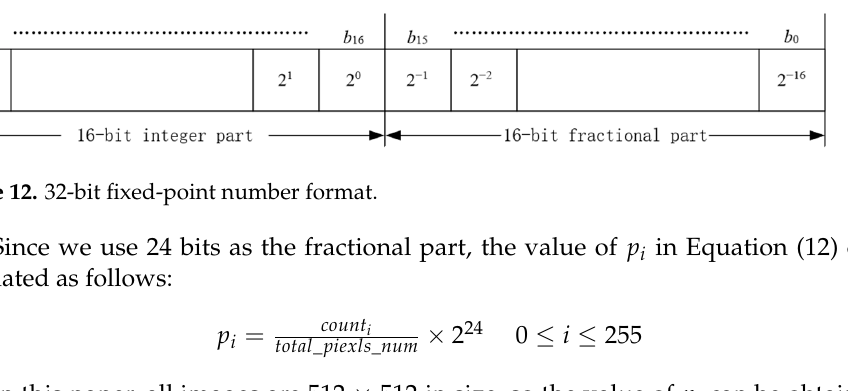
Figure 13. Architecture of Otsu’s algorithm calculation. (c) 32-bit Logarithmic Arithmetic Unit The logarithmic number system (LNS) has been studied to simplify arithmetic com- putations to achieve a lower computation complexity [26–28]. Here, a 32-bit logarithmic arithmetic unit suggested in [28] is adopted to compute Equation (14). Figure 14 shows the architecture of the logarithmic converter. It is composed of a 32-bit count leading zero (CLZ), a barrel shifter (BSH), a characteristic generator (CGen), and a fractional part gen- eration block (FPGen). The variable input number range Qm.n. is modified to the fixed number range of Q6.26. at the end of the logarithmic converter. The CLZ block calculates the number of leading zero bits of the input. The five bits of the CLZ block output deter- mine the characteristic value and the amount of shift value of the BSH. BSH converts the input number range of Qm.n. to Q6.26. After the shifting operation, the fractional part is generated by the FPGen block, and the characteristic part is generated by the CGen block. The above two values are combined to give the logarithmic conversion result.